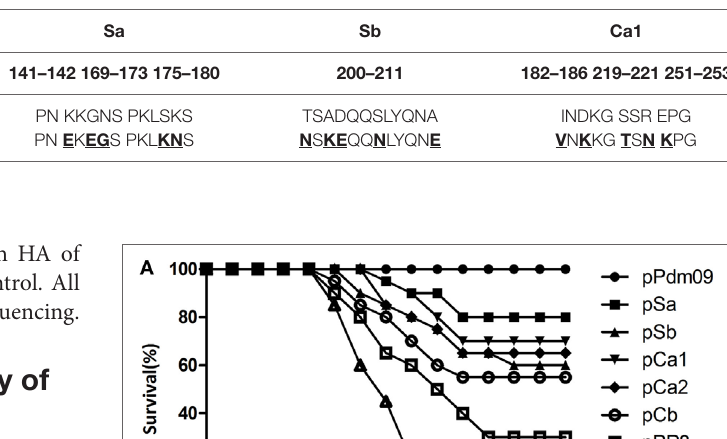
TaBle 1 | Comparison of amino acid sequence of neutralizing epitopes of the Pdm09 HA and PR8 HA (H1